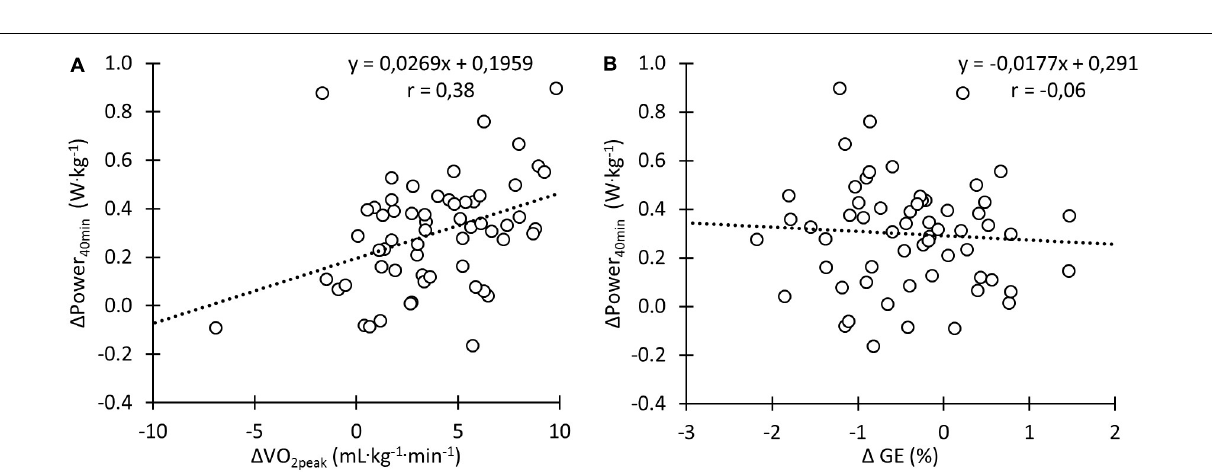
Frontiers in Physiology |